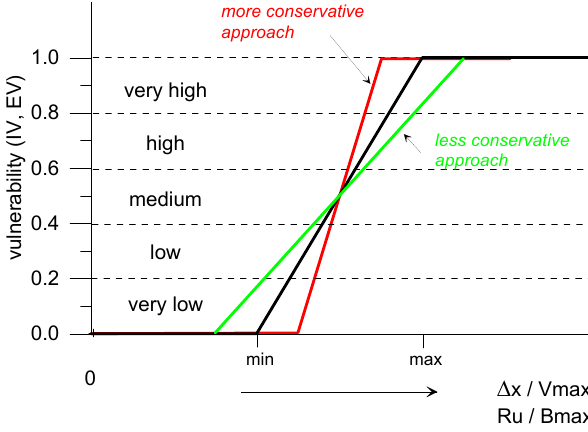
Fig. 8. Functional relationships to describe the vulnerability indica- tor in the function of the level of awareness. Red line is used in this